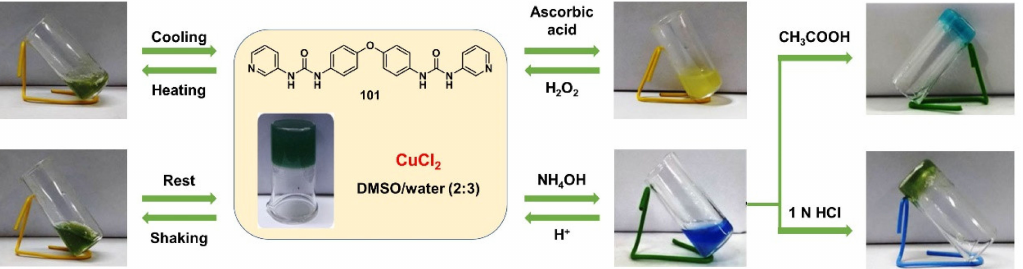
Figure 44. Molecular structure of ligand 101 and the stimuli-responsive behavior of Cu-101 gels. Reprinted with permission from Ref. [123]. Copyright (2018), John Wiley and